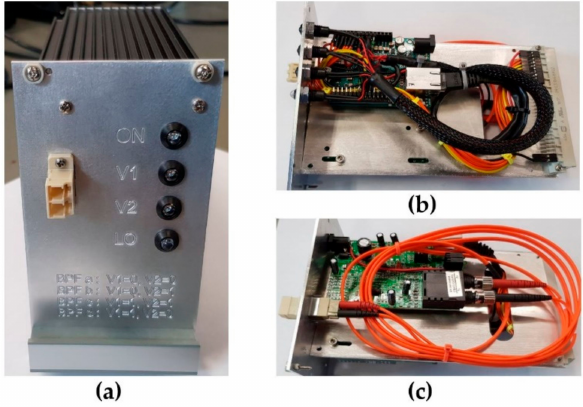
Figure 15. Warm Section control module and its parts. ( a ) Front panel with TX / RX multimode fiber connector pair and LEDs. ( b ) Microcontroller by Arduino Leonardo ETH. ( c ) Optical fiber to Ethernet media-converter (Digitus DN-82010, Lüdenscheid,